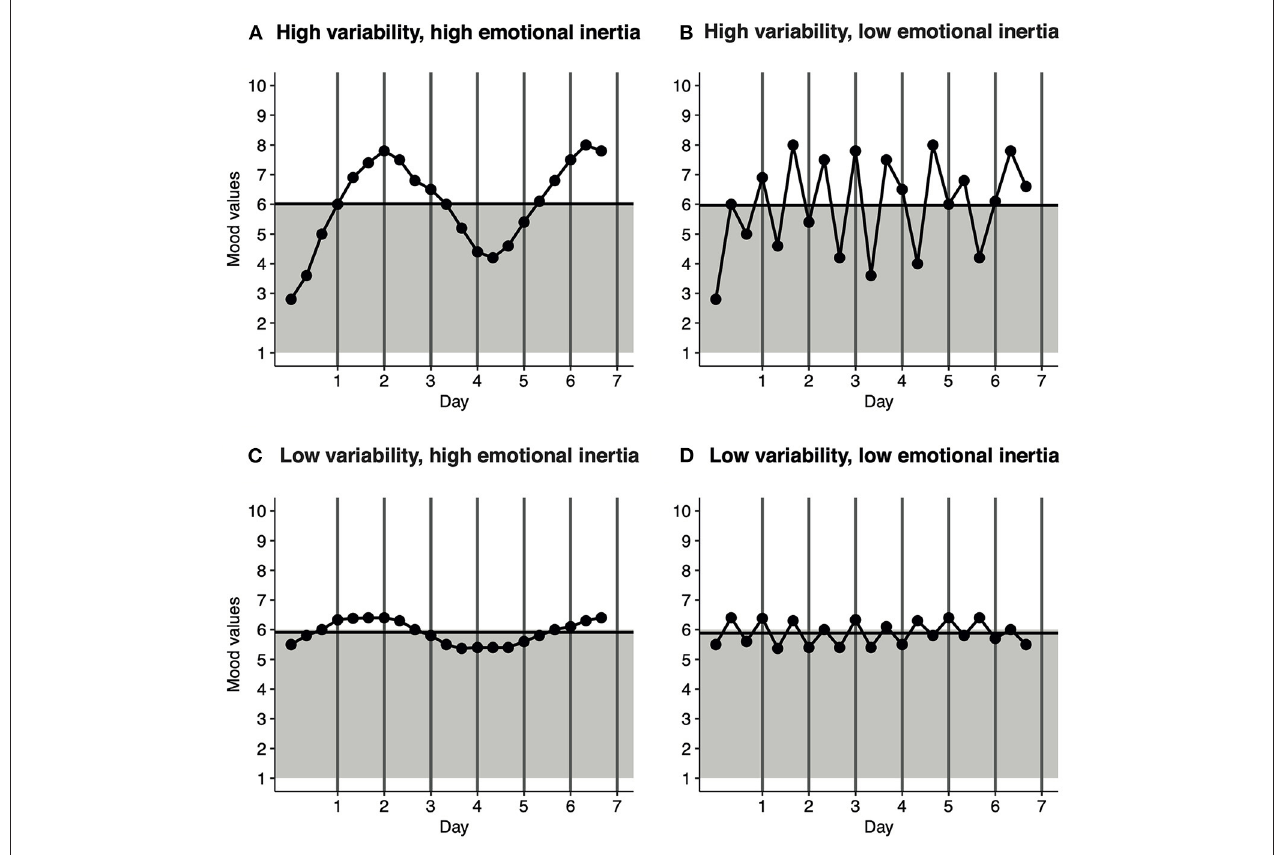
FIGURE 1 | Generated mood dynamic patterns that show different combinations of mood variability and emotional inertia. There were three measurement points over the course of a day. The gray background represents a negative mood (score < 6), while the white area represents a positive mood ( ≥ 6). The horizontal black line represents the Average Mood across the 7-day monitoring period. For each panel, the average mood was ∼ 6. (A) High variability, high emotional inertia. (B) High variability, low emotional inertia. (C) Low variability, high emotional inertia. (D) Low variability, low emotional